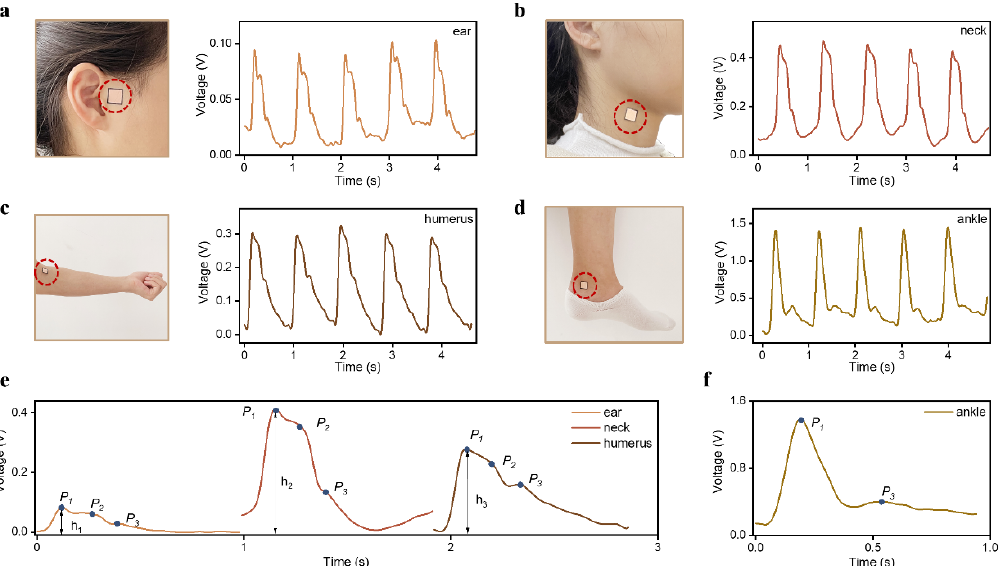
Figure 4. Human pulse wave monitoring at different body parts: ( a ) ear, ( b ) neck, ( c ) humerus, and ( d ) ankle; ( e ) pulse wave at different parts of the human body over one cycle; and ( f ) one cycle of pulse wave measured at the ankle. ‘